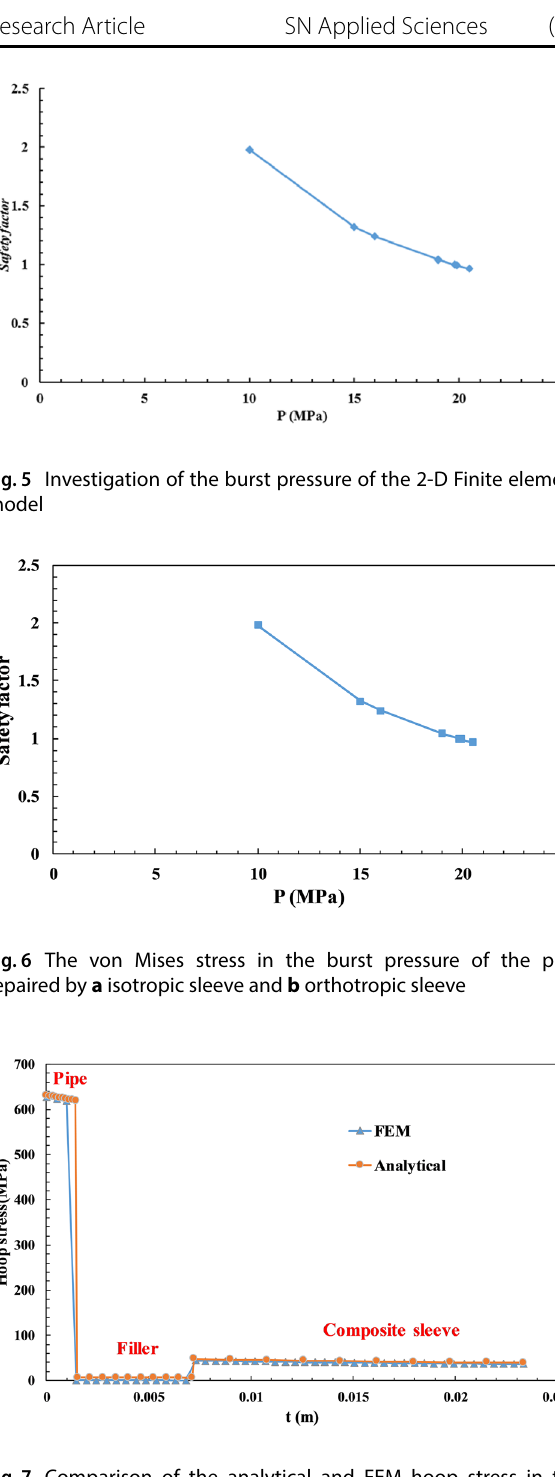
Fig. 7 Comparison of the analytical and FEM hoop stress in the burst pressure of the repaired pipe